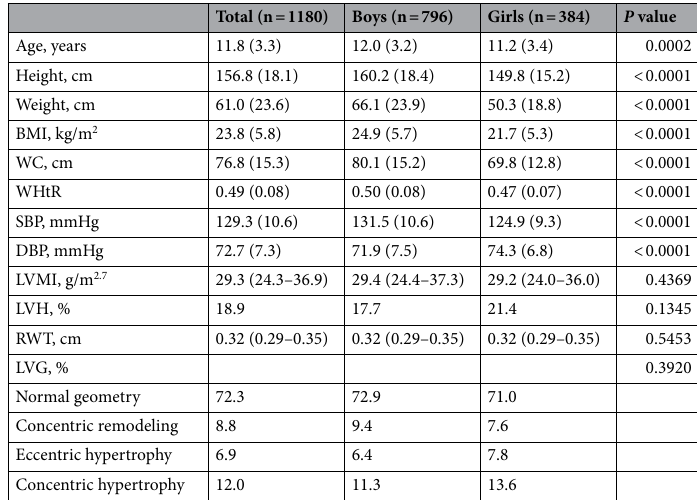
Table 1. Characteristics of study population. Continuous variables are presented as mean (SD) if they are in normal distribution or median (P25-P75) if not. BMI, body mass index; WC, waist circumference; WHtR, waist-to-height ratio; SBP, systolic blood pressure; DBP, diastolic blood pressure; LVMI, left ventricular mass index; LVH, left ventricular hypertrophy; RWT, relative wall thickness; LVG, left ventricular geometry.